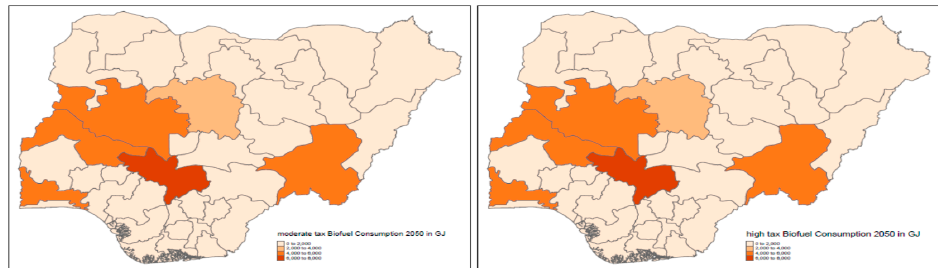
Figure 11. Biofuel consumption by 2050 under no subsidy action.